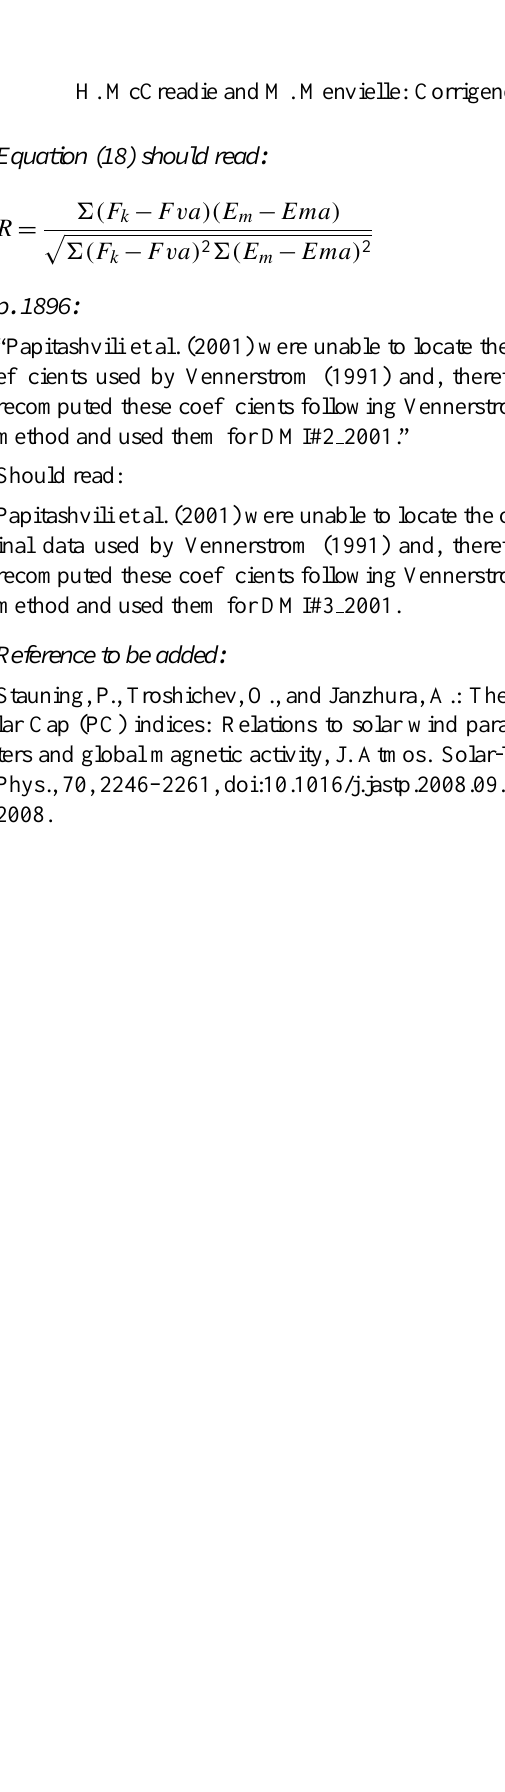
8. Figure 5 aims at summarizing on the same schematic di- agram the definition of all the elements that are referred to in the paper. The explanations given below clarify and complement the caption of this